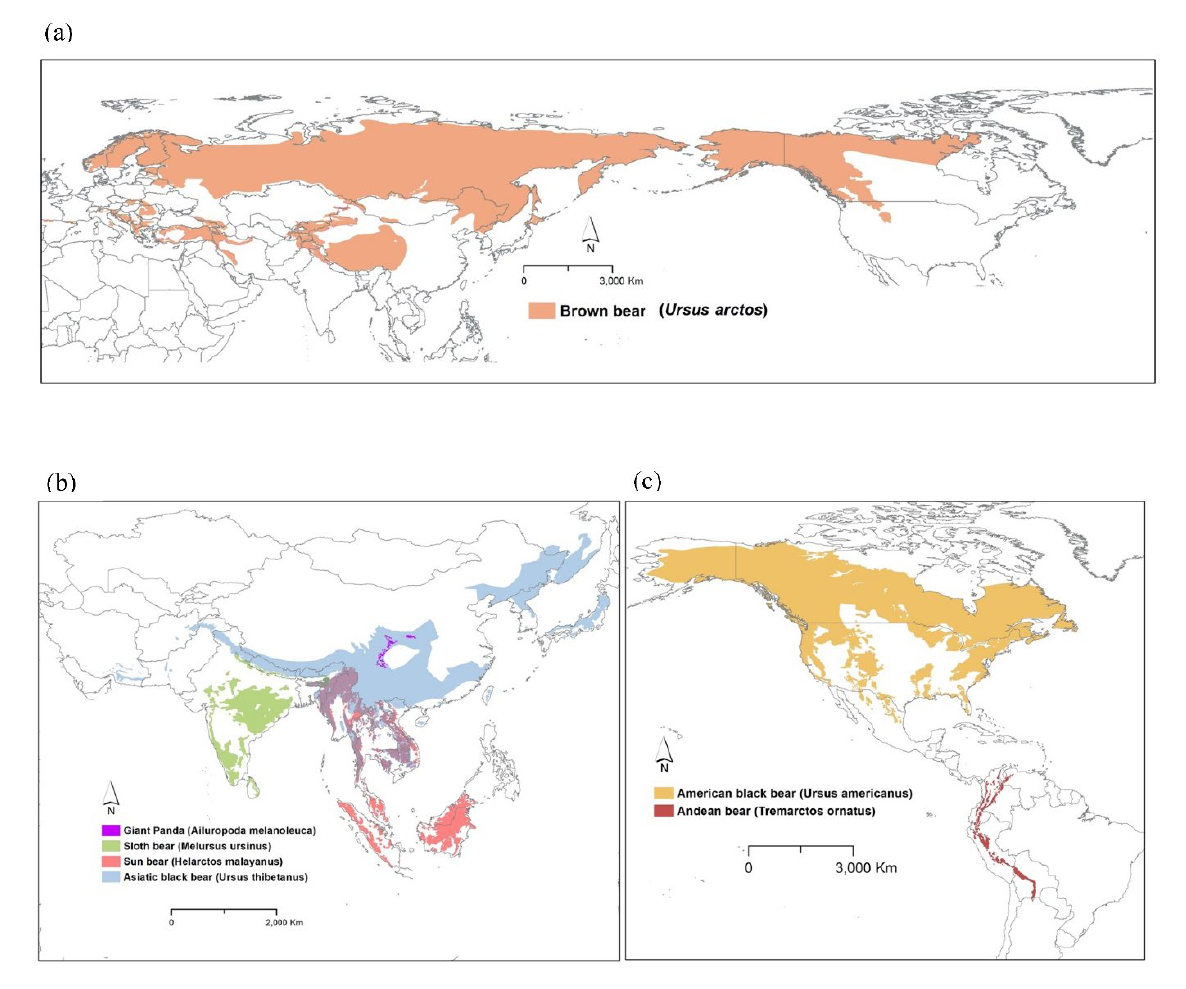
Figure 1. ( a ) The brown bear ranges across three continents (and once ranged into North Africa). ( b ) The Asiatic black bear, sun bear, sloth bear, and giant panda are all endemic to Asia, and their ranges at least partially overlap on a broad scale. ( c ) The American black bear is endemic to North America (3 countries), and the Andean bear is endemic to South America (5 countries). Depicted here is the maximum present range, combining categories for extant and possibly extant range from the IUCN (International Union for Conservation of Nature) Red List.